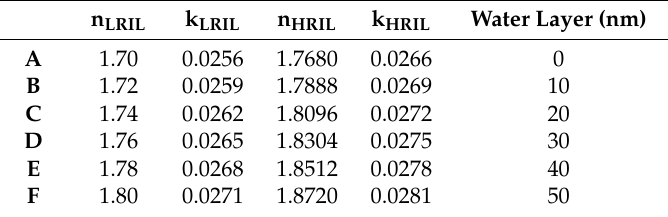
Table 2. Simulation parameters for the study of the effect of humidity on indium oxide.